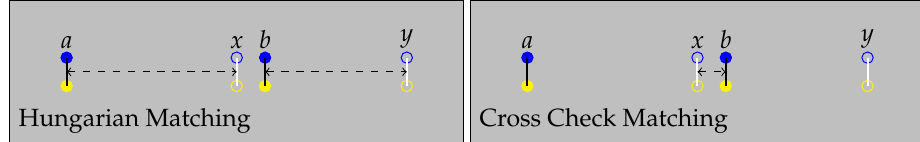
Figure 9. Example with two ground truth instance locations (solid circles connected with black lines) and two detected instances (empty circles connected with white lines) using matching results achieved with both the Hungarian algorithm and the proposed cross-check matching of Equations (9) and (10). While the detection x and ground truth location b in the middle are clearly nearest neighbors of one another, they are not matched by the Hungarian algorithm. Instead, in an effort to minimize the global matching cost, the Hungarian algorithm will assign a to x and b to y . In contrast, the cross-check matching method leaves the outer detection y and ground truth location a unmatched while assigning the two in the middle, x and b ,